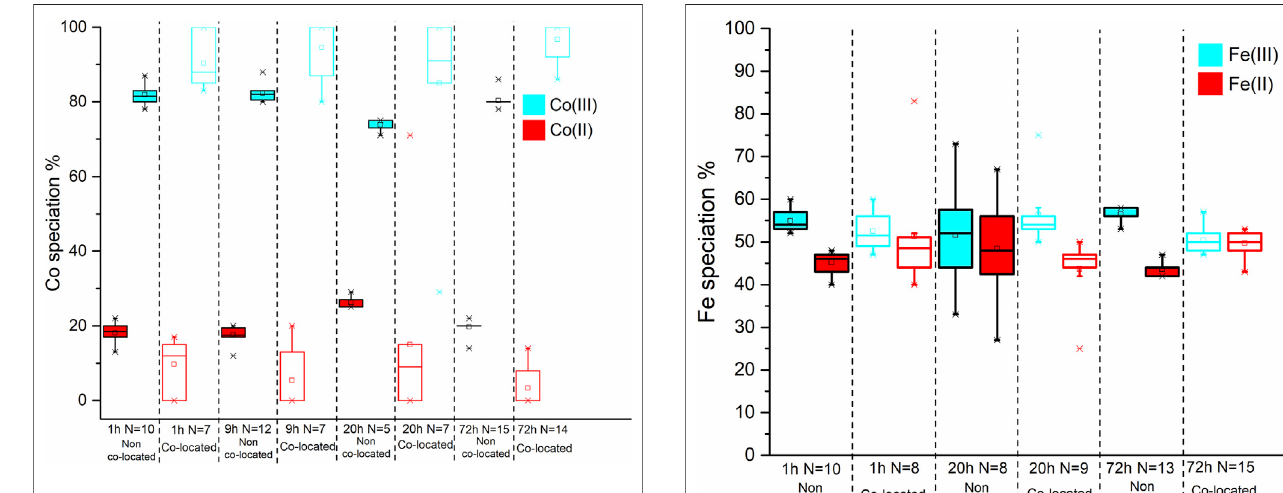
Table S2 ) indicating that cells had a varying metabolic potential and therefore identifying heterogeneity within the system. Fe L 2,3 edge SXM data at the nano scale indicated no spatial changes in Fe speciation from 1 h as the Fe(II):Fe(III) ratio in the system had spatially stabilised whilst the Co(II):Co(III) ratio was still evolving.